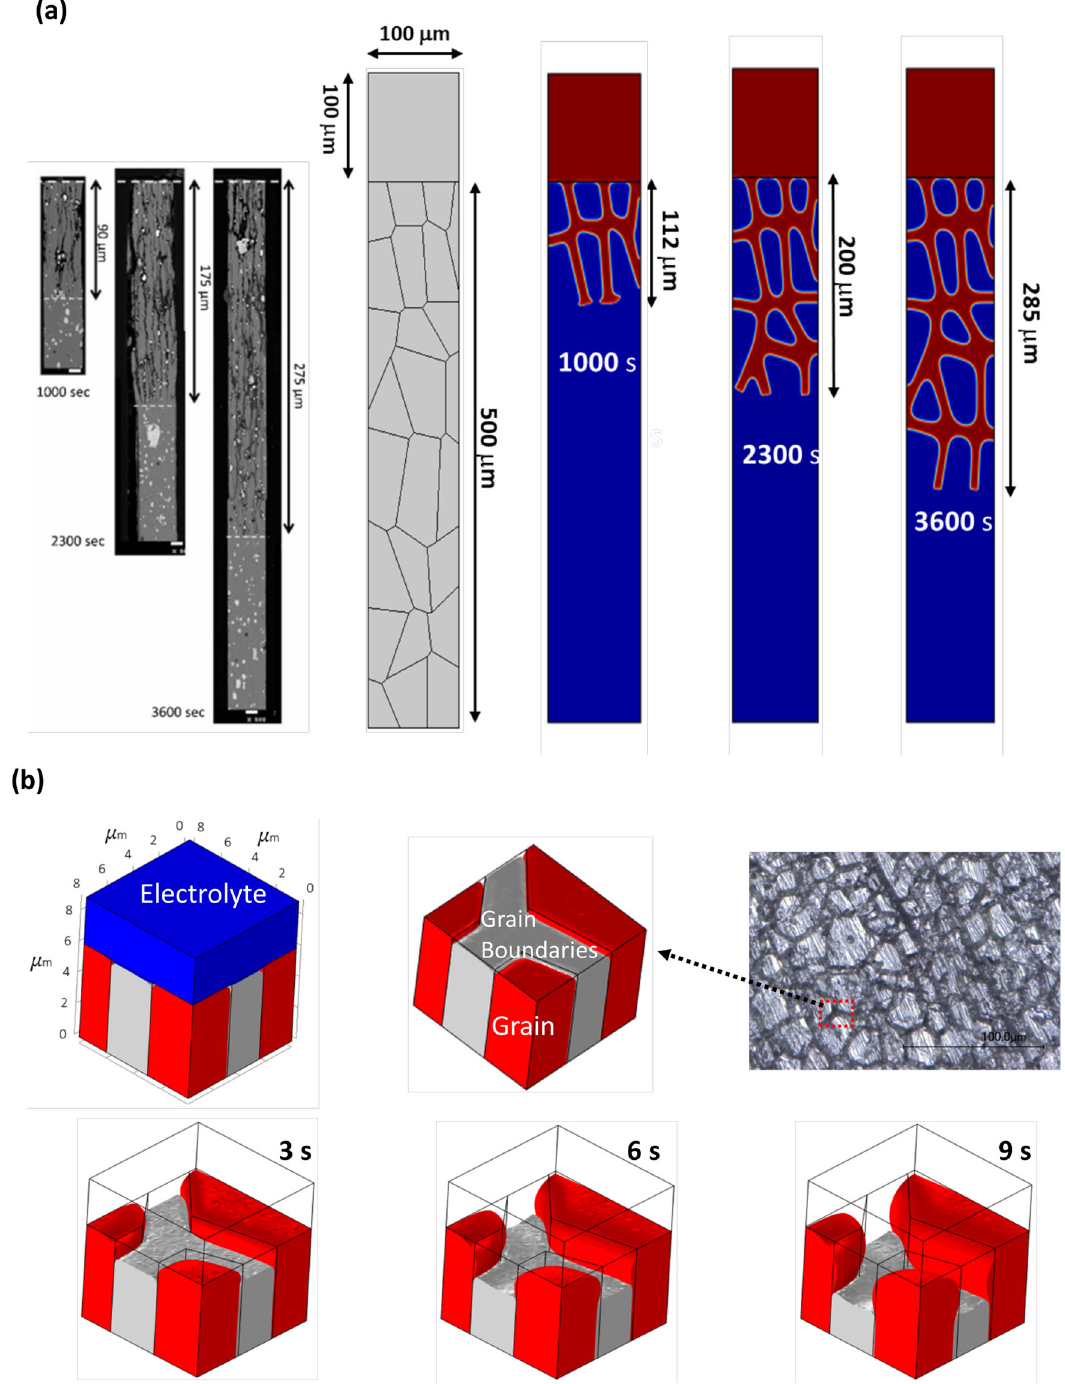
Fig. 5 Intergranular corrosion Kinetics. a Evolution of IGC in a sensitized steel sample and comparison with optical image microscopy snapshots from an experimental study 112 . b Depiction of a 3-D study on IGC kinetics 80 . a is reproduced with permission from ref. 112